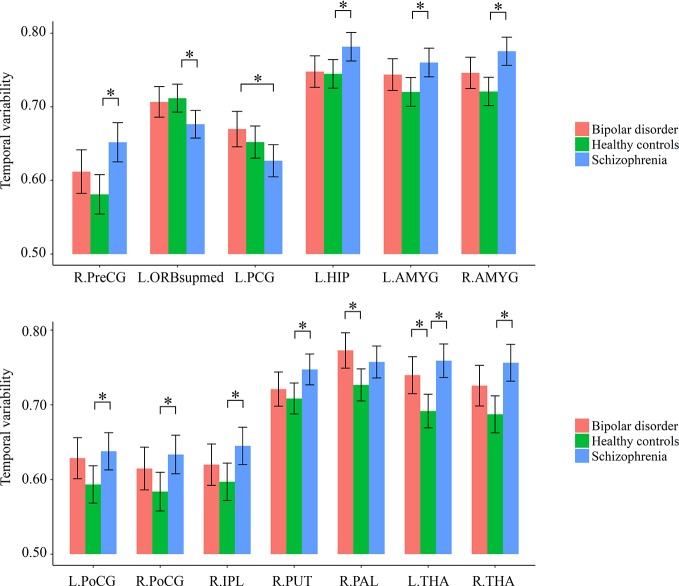
Group differences in the temporal variabilities of regional FC patterns. The error bars present the 95% confidence intervals, and the marks “*” indicate significant between-group differences with corrected p < 0.05. AMYG, amygdala; FC, functional connectivity; HIP, hippocampus; IPL, inferior parietal lobule; L, left hemisphere; ORBsupmed, superior frontal gyrus (medial orbital); PAL, pallidum; PCG, posterior cingulate gyrus; PoCG, postcentral gyrus; PreCG, precentral gyrus; PUT, putamen; R, right hemisphere; THA, thalamus.